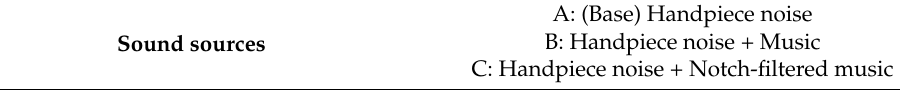
Figure 5. Noise masking process for experiments.